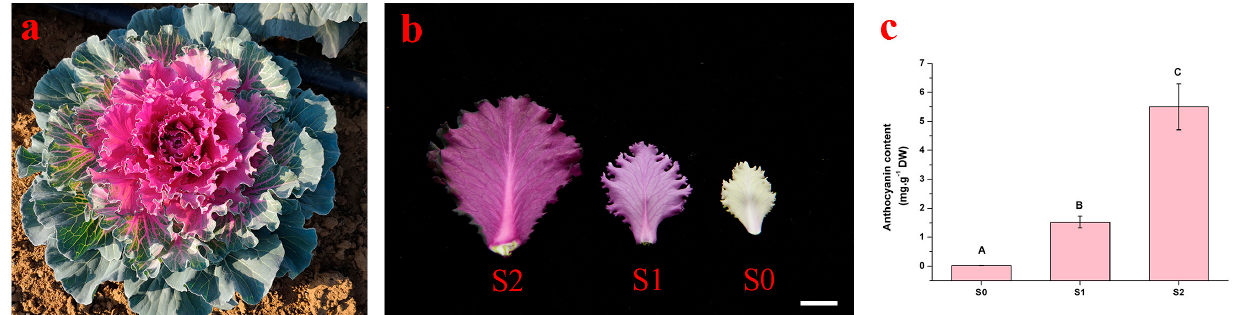
Figure 1. Phenotype and pigment accumulations in the new leaves at different developmental stages. ( a ) The whole plant morphology of ‘Y007-P-24 ′ ; ( b ) The new leaves phenotype of ‘Y007-P-24 ′ at different developmental stages. Bars = 1 cm; ( c ) The anthocyanin contents at S0–S2. Different capital letters show significant differences based on an analysis of variance (Tukey’s test, p ≤ 0.01).